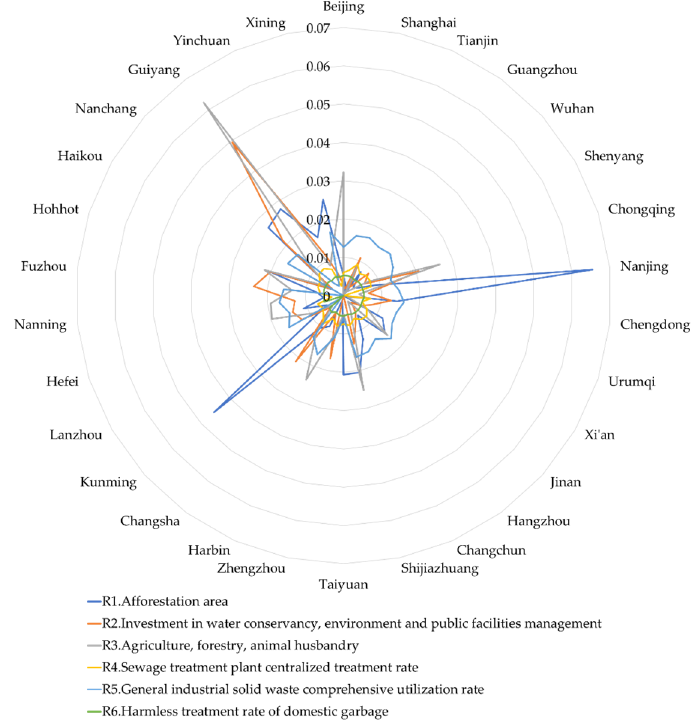
Figure 10. Weighted comparison of sub-indicators in response index.